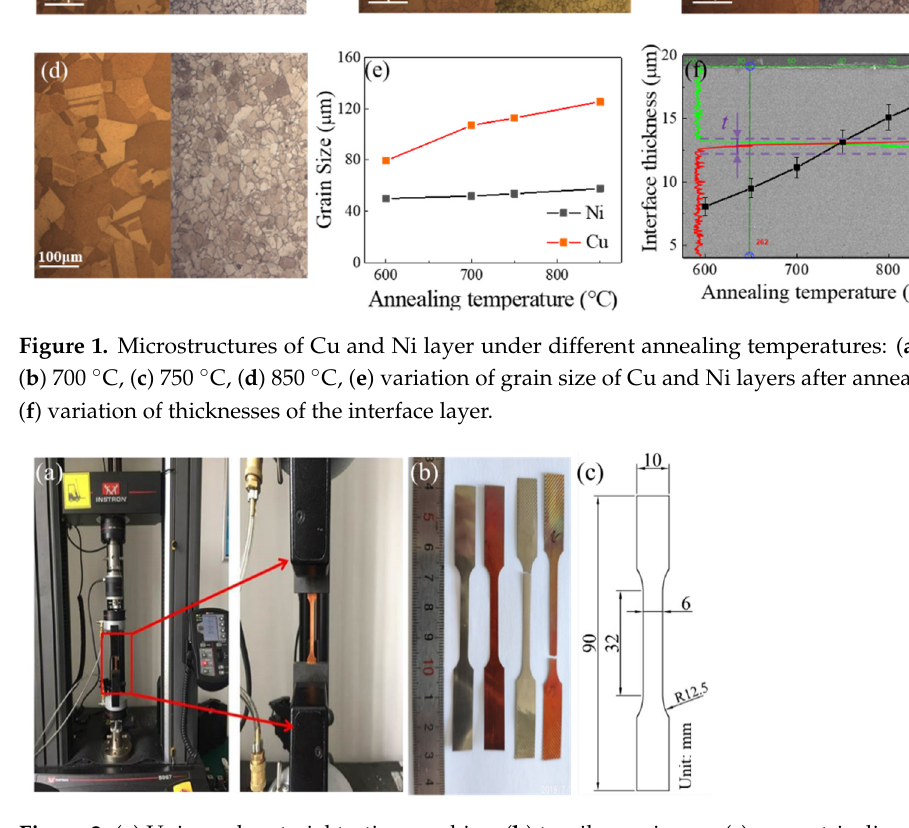
Figure 2. ( a ) Universal material testing machine; ( b ) tensile specimens; ( c ) geometric dimensions of tensile specimens.